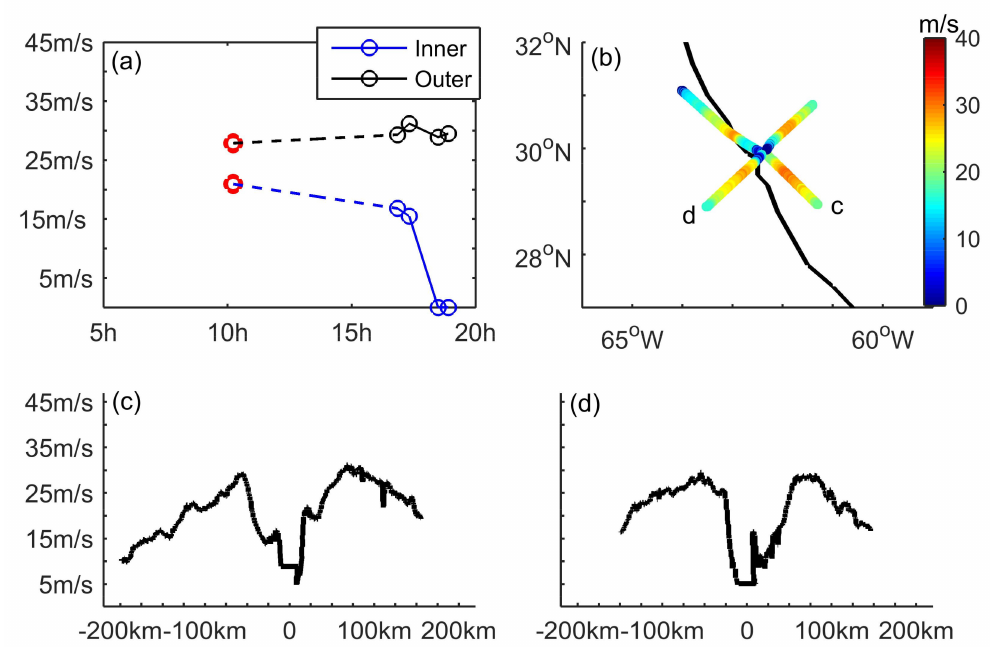
Figure 6. ERC dynamic process of Hurricane Bertha measured by aircraft SFMR: ( a ) hurricane intensities of the double-eye structure, ( b ) flight tracks, as well as ( c ), ( d ) the respective complete profiles along